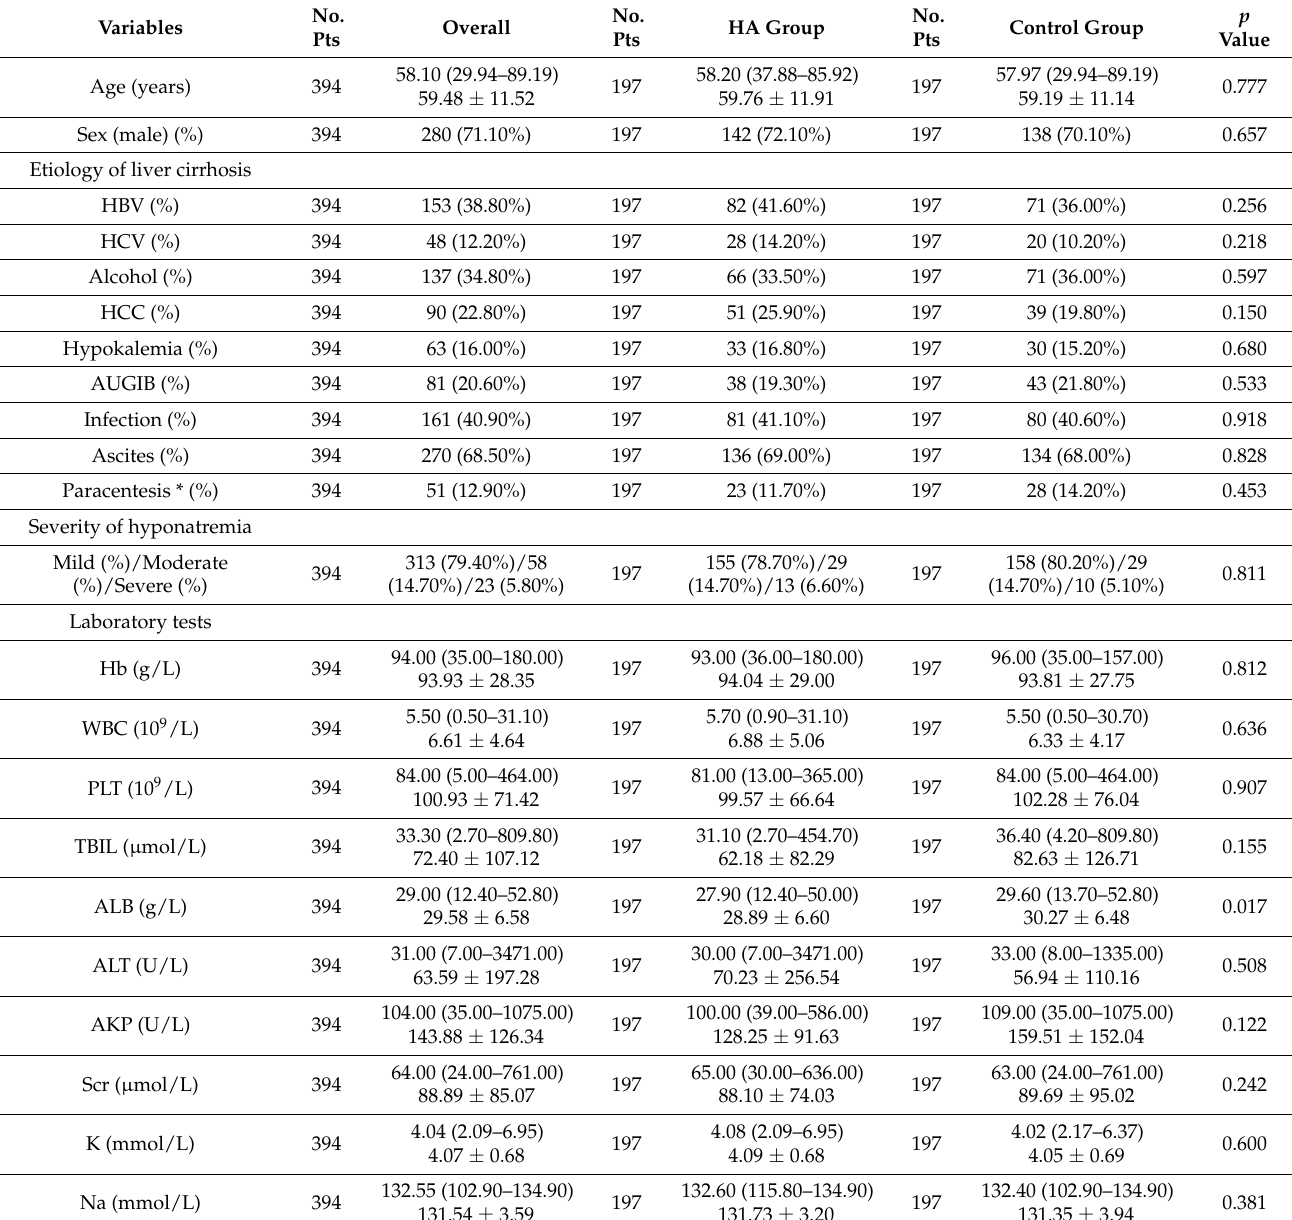
Table 2. Hospitalization outcome cohort—Characteristics of patients in the treatment study after